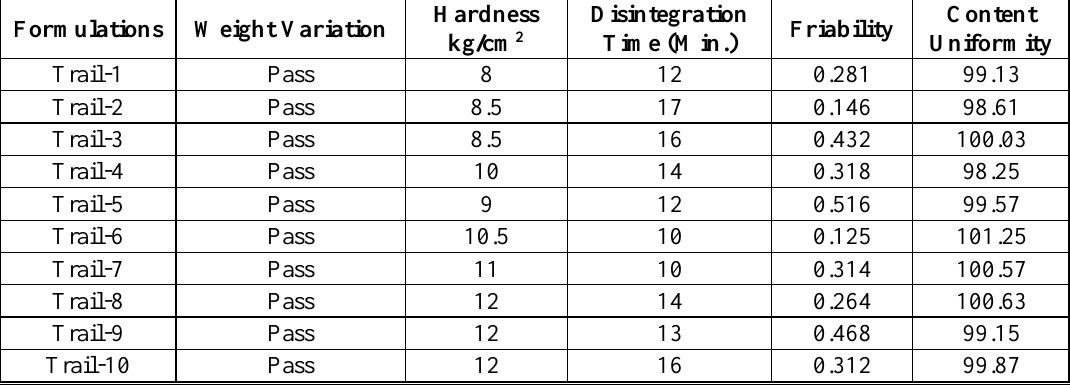
Table 4. Post compression parameters of raltegravir HME tablets